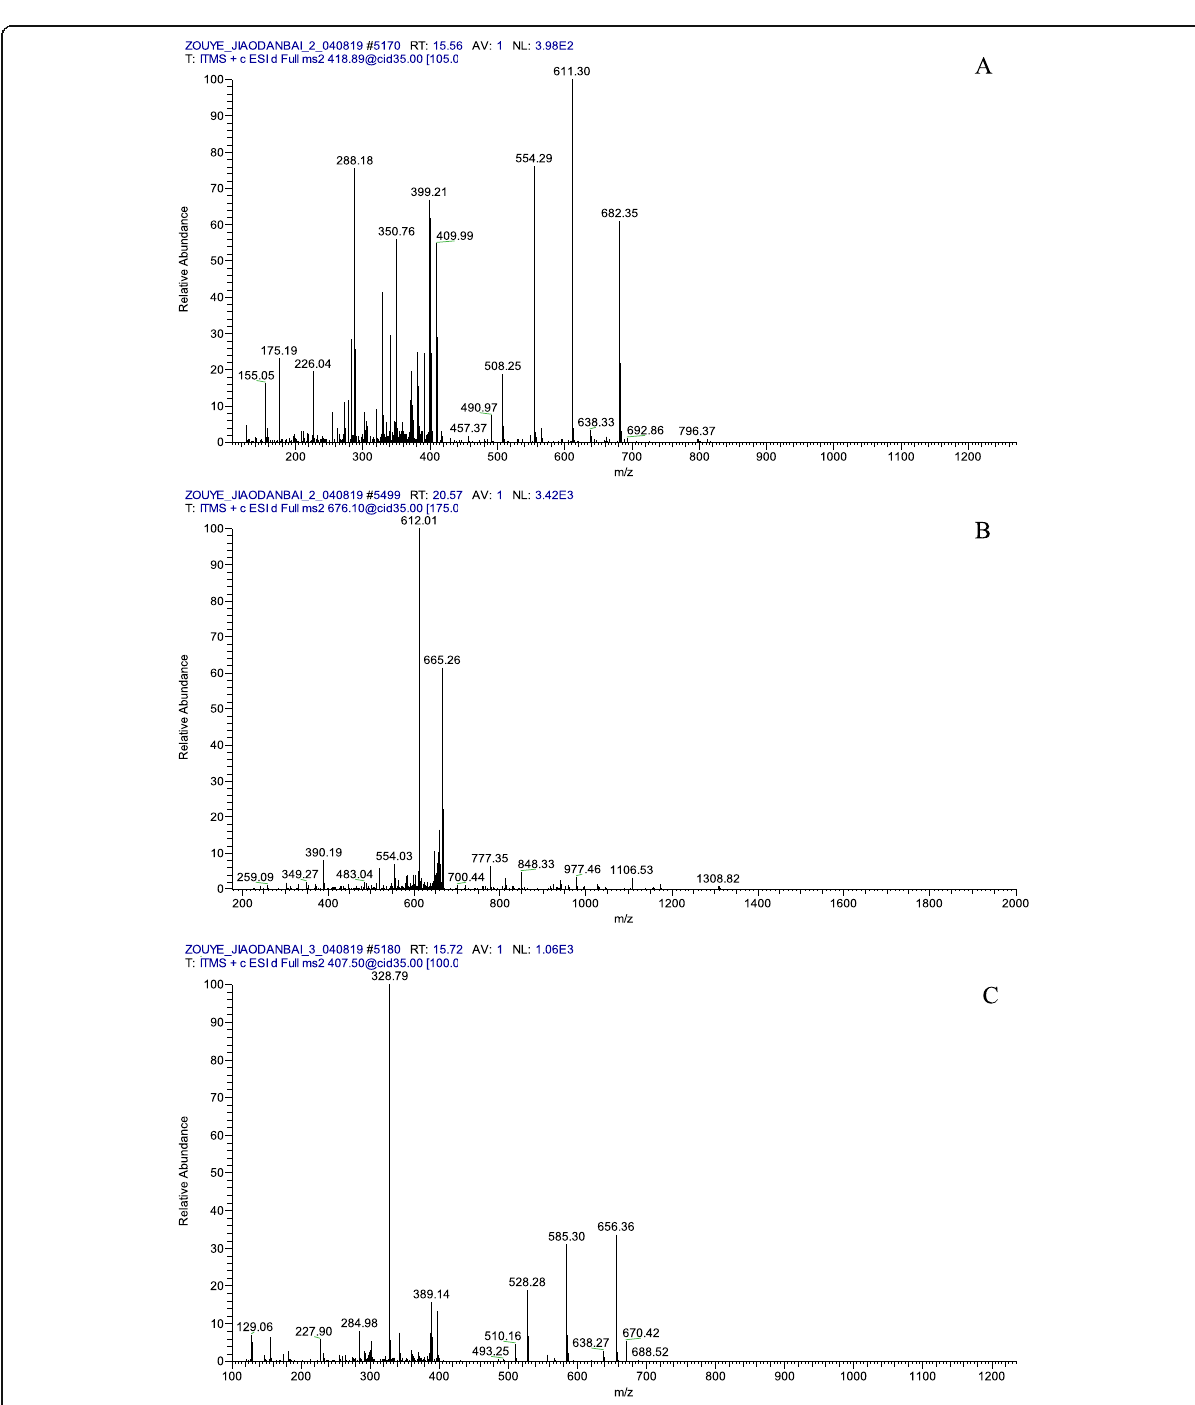
Fig. 8 MS fingerprints of main collagen from chicken lung. Sequencing peptide: a GPAGPQGPR, b QLEEAEEESQR and ( c ) GVAGPQGAR,